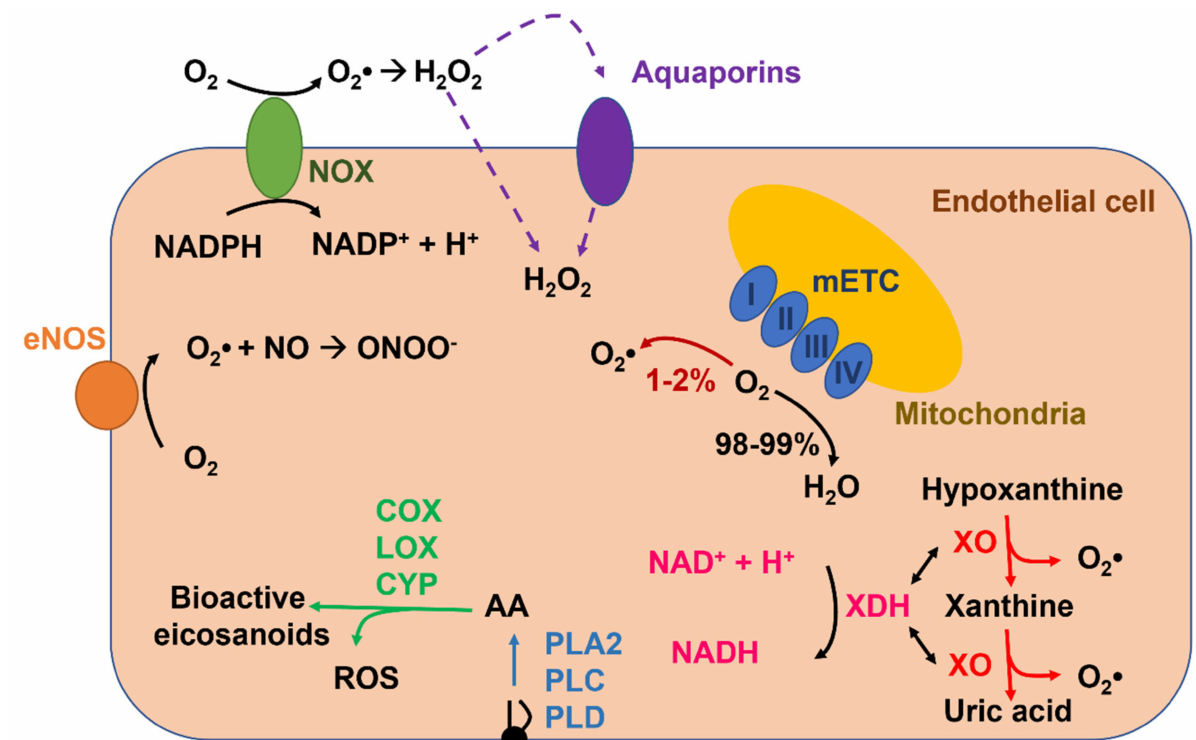
Figure 1. Major mechanisms of ROS production in vascular endothelial cells. The enzyme NADPH oxidase (NOX; green) catalyzes the transfer of an electron from NADPH to O 2 , generating O 2 • − in the extracellular